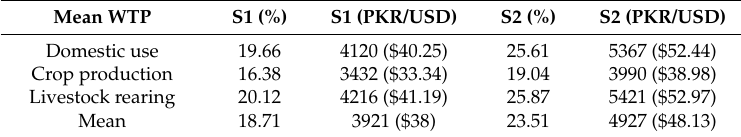
Table 5. Mean WTP for domestic, agriculture, and livestock purposes.